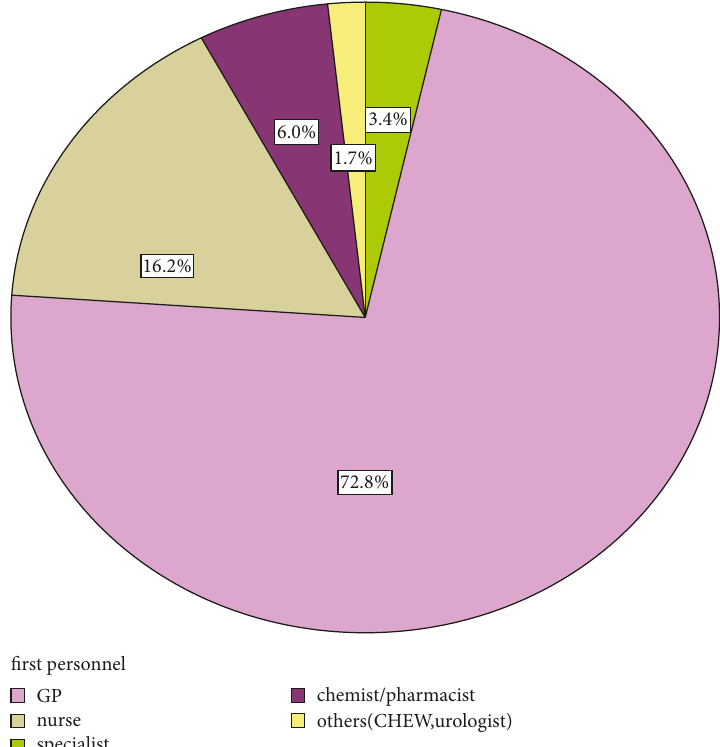
Figure 1: First healthcare provider (FHP) consulted: two-thirds of patients first visited a doctor who was a general